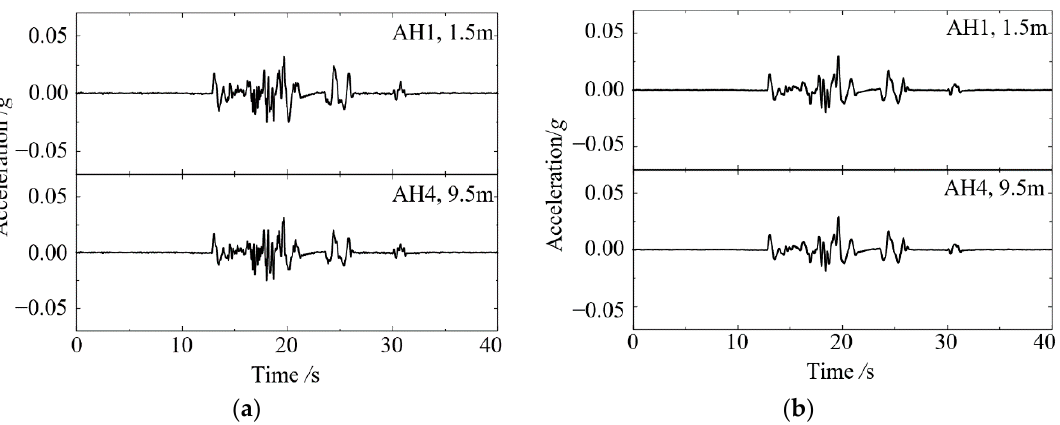
Figure 15. The acceleration time history of accelerometers AH1 and AH4: ( a ) experimental result; ( b ) simulation result. Table 4. The comparison of peak acceleration for simulation and experimental results.